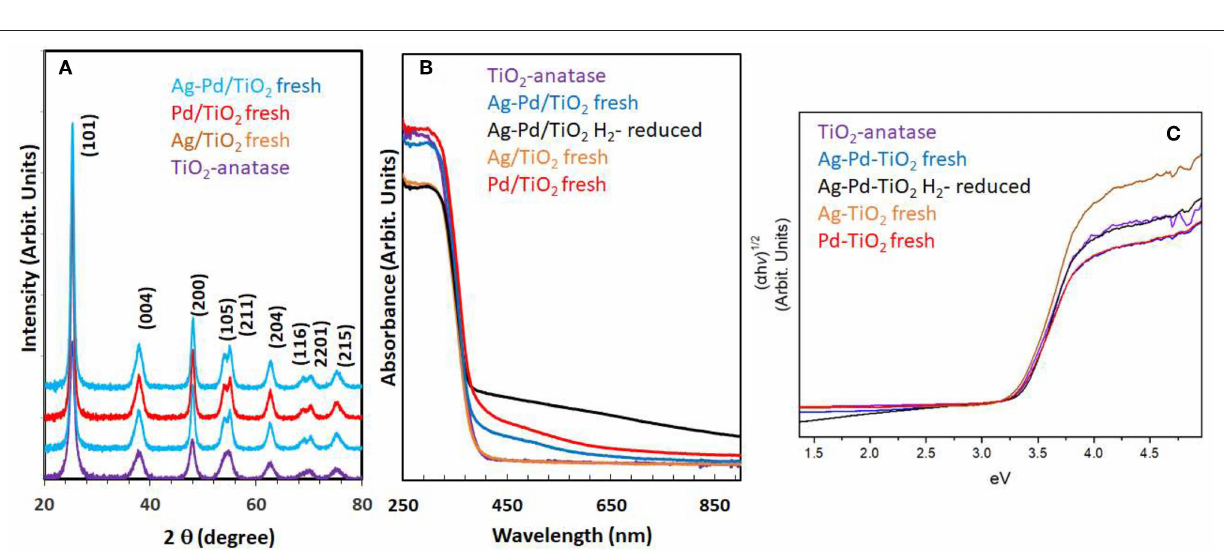
allowed transition, = 3/2 for direct forbidden transition, = 2 for an indirect allowed transition and = 3 for indirect forbidden transition within a semiconductor material. In